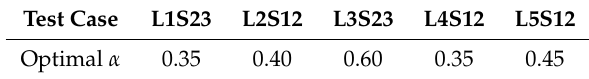
Table 4. Optimal regularisation factor minimising the time difference error variance in field